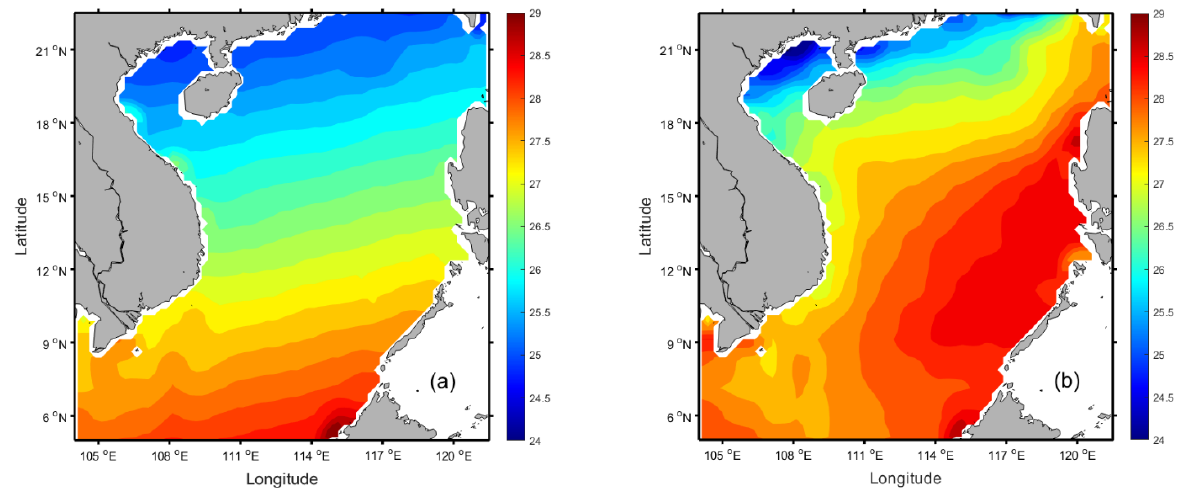
8 of 15 Figure 4. The estimated background SST distribution (unit: °C). In the two ideal experiments, the mean absolute error (MAE) between the simula- tions and the “observations” was reduced from 1.74 °C and 1.87 °C without data assimi- lation to 0.13 °C and 0.14 °C, respectively, by applying the adjoint assimilation model. Due to the large number of observation data and high resolution of SST, spatial distribution characteristics could be observed more obviously. The initial SST obtained by inversion is